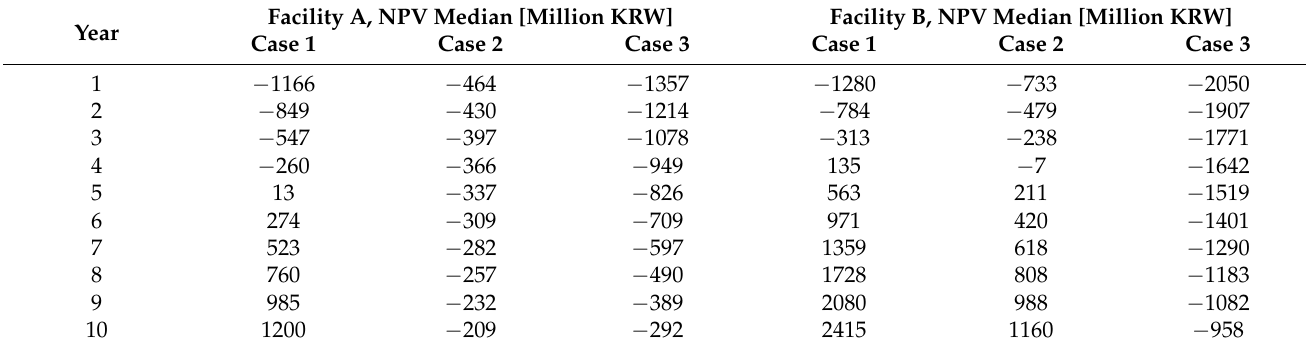
Table 8. NPV simulation median value